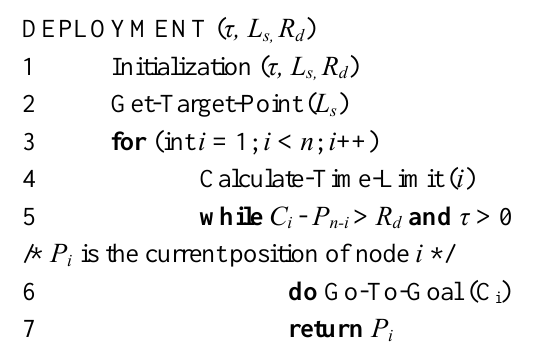
Figure 16. Pseudocodes of the algorithm for autonomous deployment.